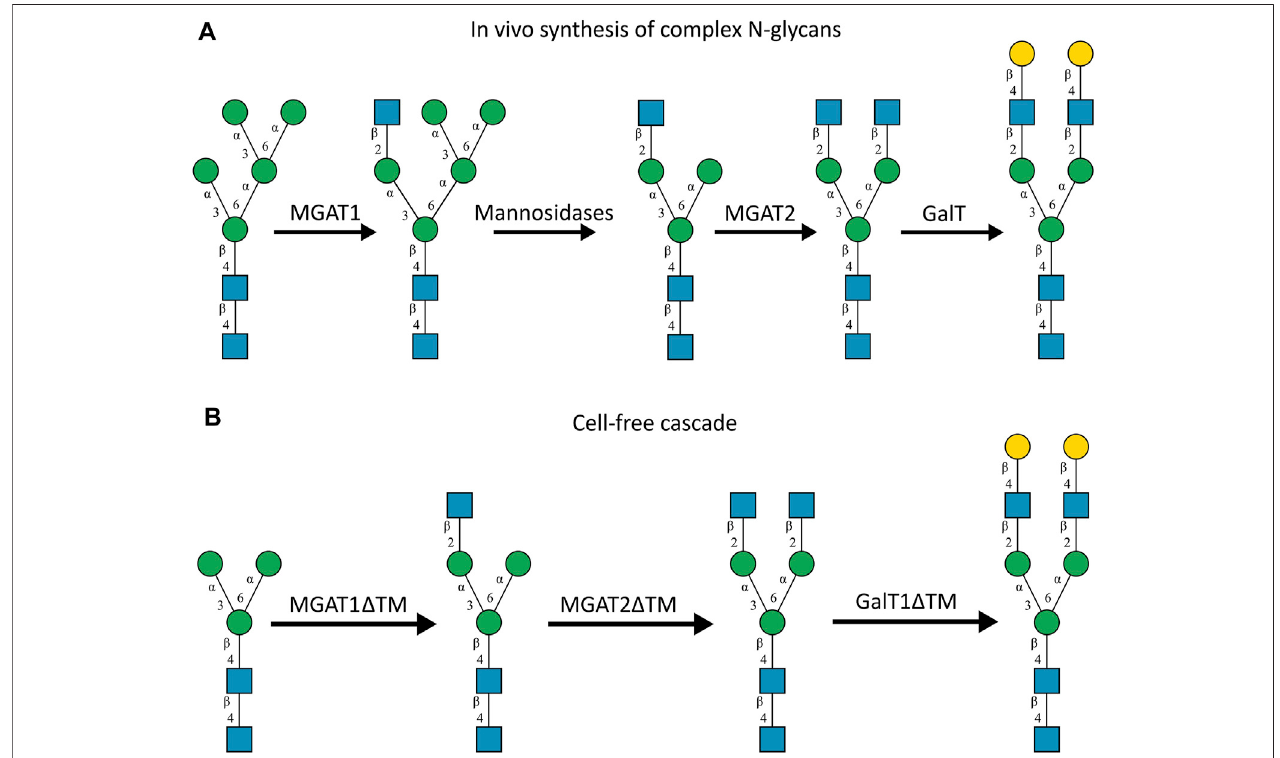
FIGURE 1 | (A) In-vivo the oligomannose-type N -glycan Man5 is converted into complex-type N -glycans by mannosidases and MGAT1, MGAT2 and GalT. SubstratesforthesereactionsareUDP-GlcNAc andUDP-galactose,respectively. (B) Thisprocess canberemodelled in-vitro tosynthesizecomplex-typestructureson insect cell-derived recombinant proteins with paucimannose-type N-glycans, like Man3.